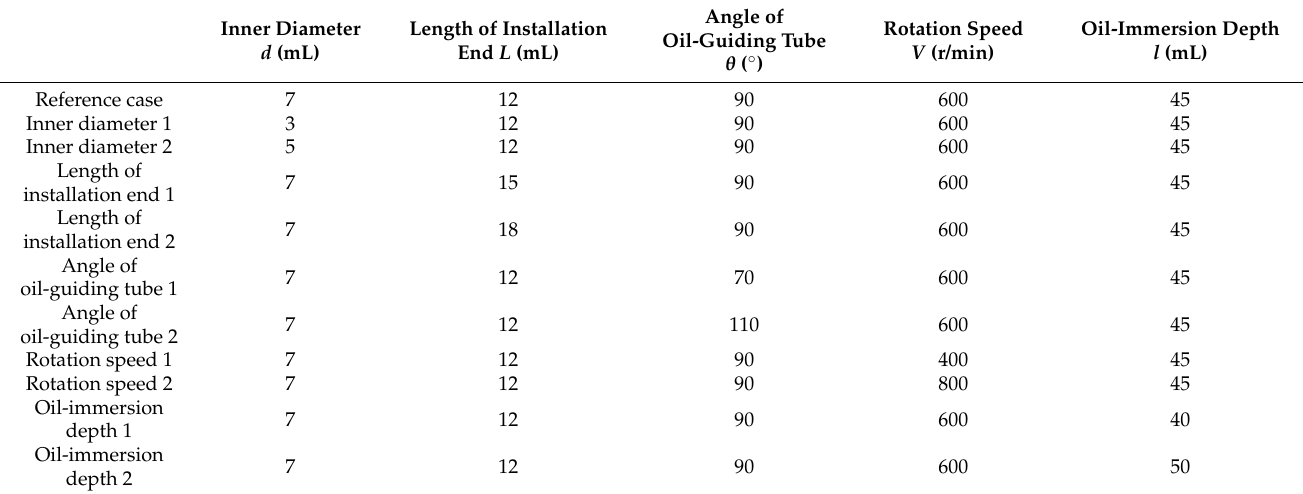
Figure 8. Geometrical parameters of the oil-guiding tube. Table 2. Conditions of operation for comparing the flow rate in the gear-meshing area.